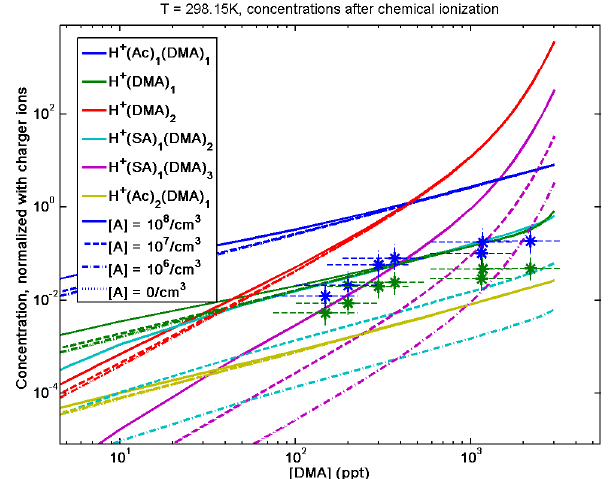
Figure 8. Modelled concentrations of charged clusters after chem- ical ionization, normalized with the remaining charger ion concen- tration after the ionization, ([H + (Ac) 1 ] + [H + (Ac) 2 ]). The stick- ing factor was 0.4 for collisions between DMA monomers and ev- erything else, and 1 for all other collisions, the neutral acetone monomer concentration was 0cm − 3 , and the initial charger ion con- centration was 10 6 cm − 3 . The stars represent the CI-APi-TOF mea- surement data, presented as the normalized average signals of ion counts per second. Green stars are for H + (DMA) 1 and blue stars are for H + (Ac) 1 (DMA) 1 . The error bars in the direction of the x axis are calculated using known sources of error and propagation of uncertainty. The error bars in the direction of the y axis represent the uncertainty in ion transmission